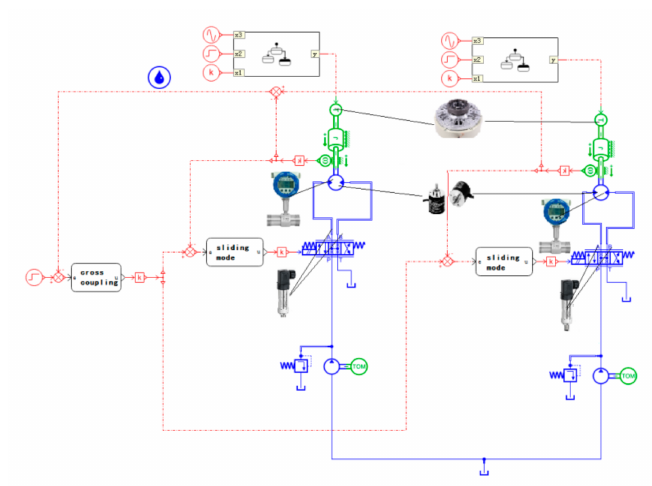
Figure 3. Simulation diagram.